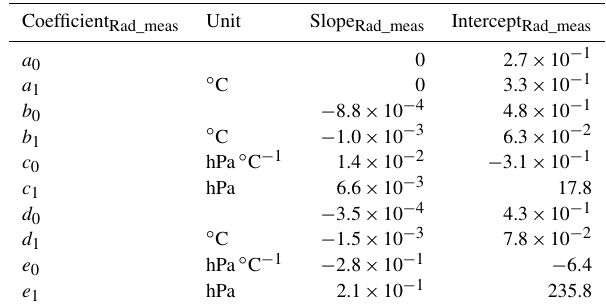
Table 1. Slope Rad_meas and Intercept Rad_meas of a 0 , a 1 , b 0 , b 1 , c 0 , c 1 , d 0 , d 1 , e 0 and e 1